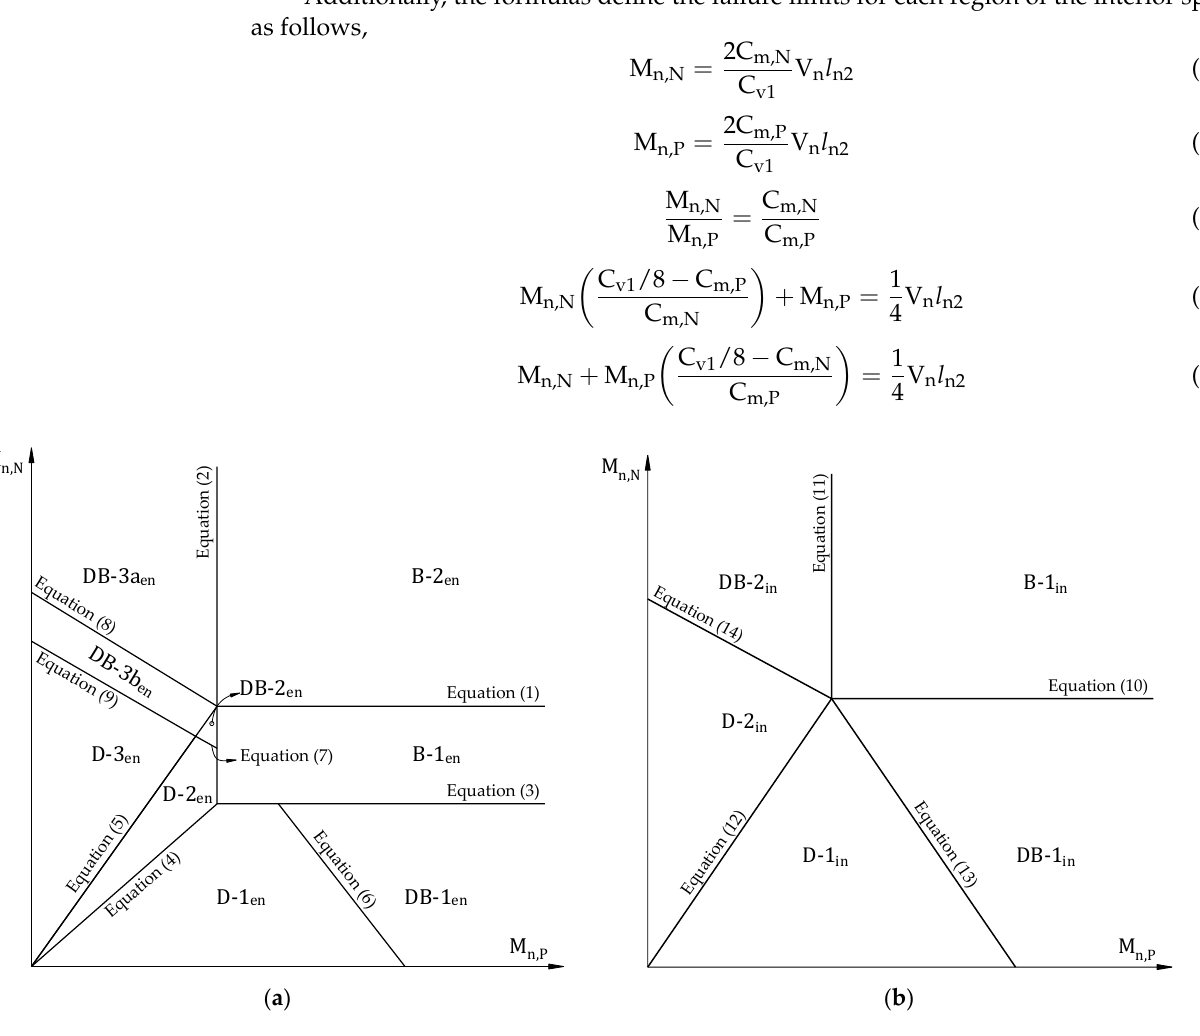
Figure 3. A classification of continuous RC slab failure modes based on moment and shear capacities: ( a ) the end span; ( b ) the interior span. Table 1. Failure modes of continuous RC slabs according to the order of plastic hinge